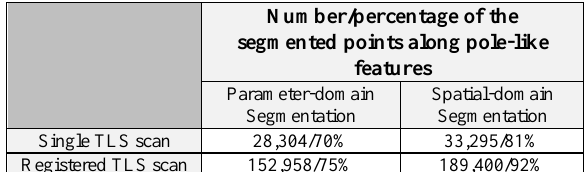
Table 1. The number/percentage of segmented points along pole-like features using the proposed parameter-domain and spatial-domain segmentation approaches